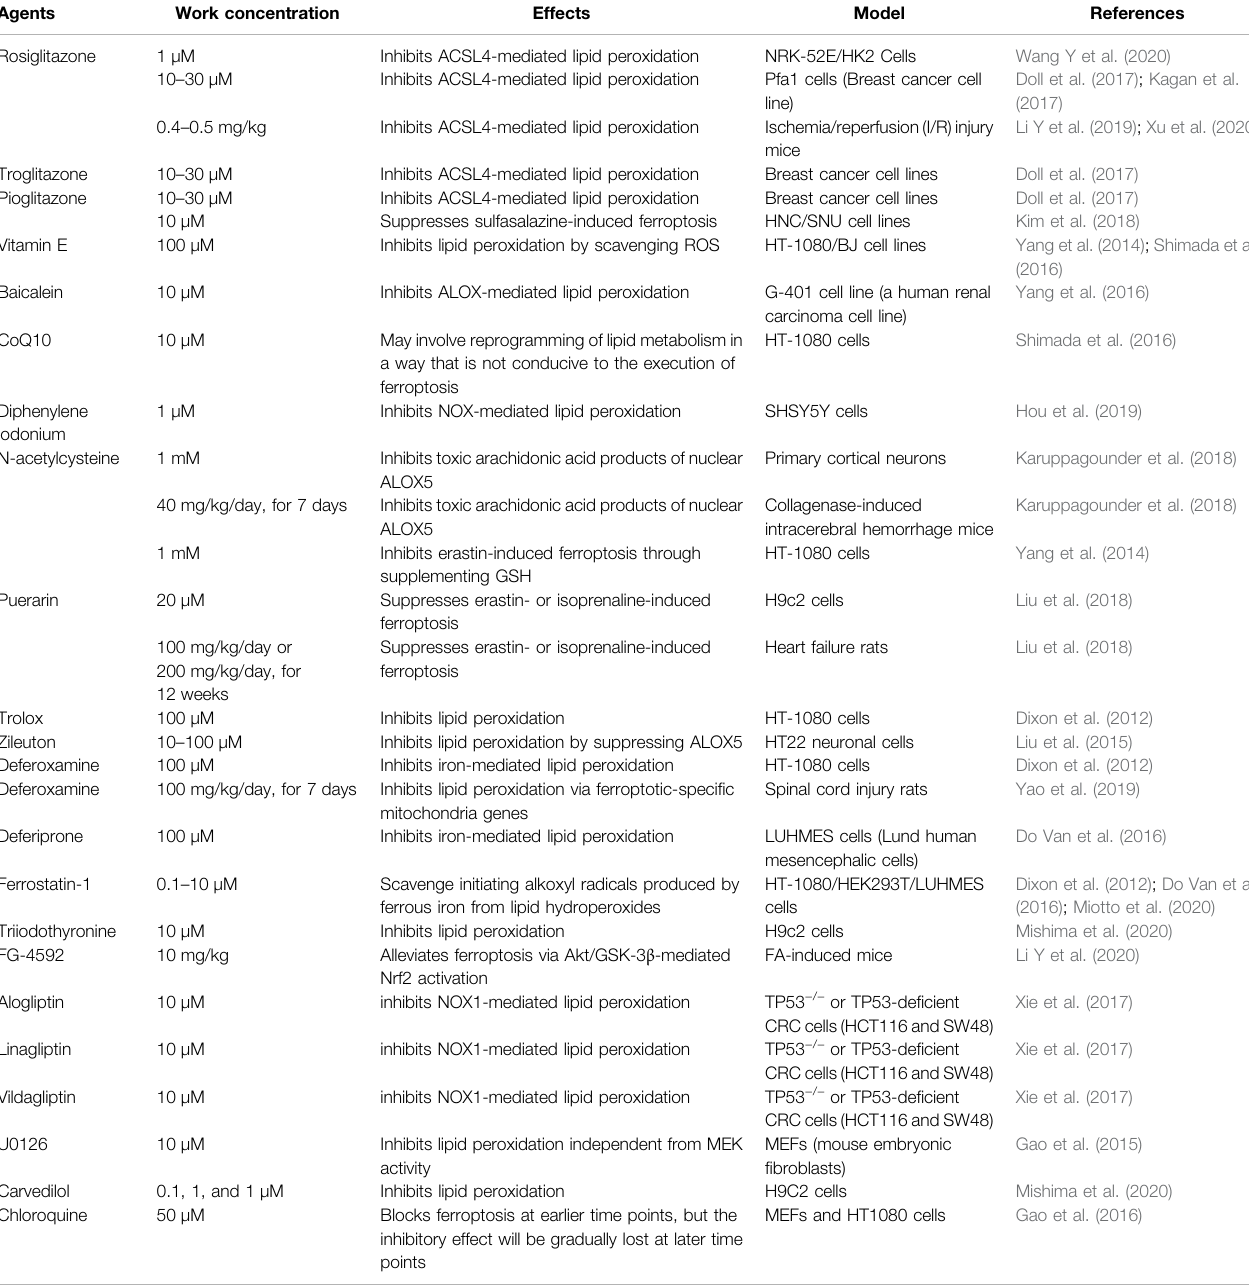
TABLE 3 | Mechanisms of ferroptosis inhibitors restraining